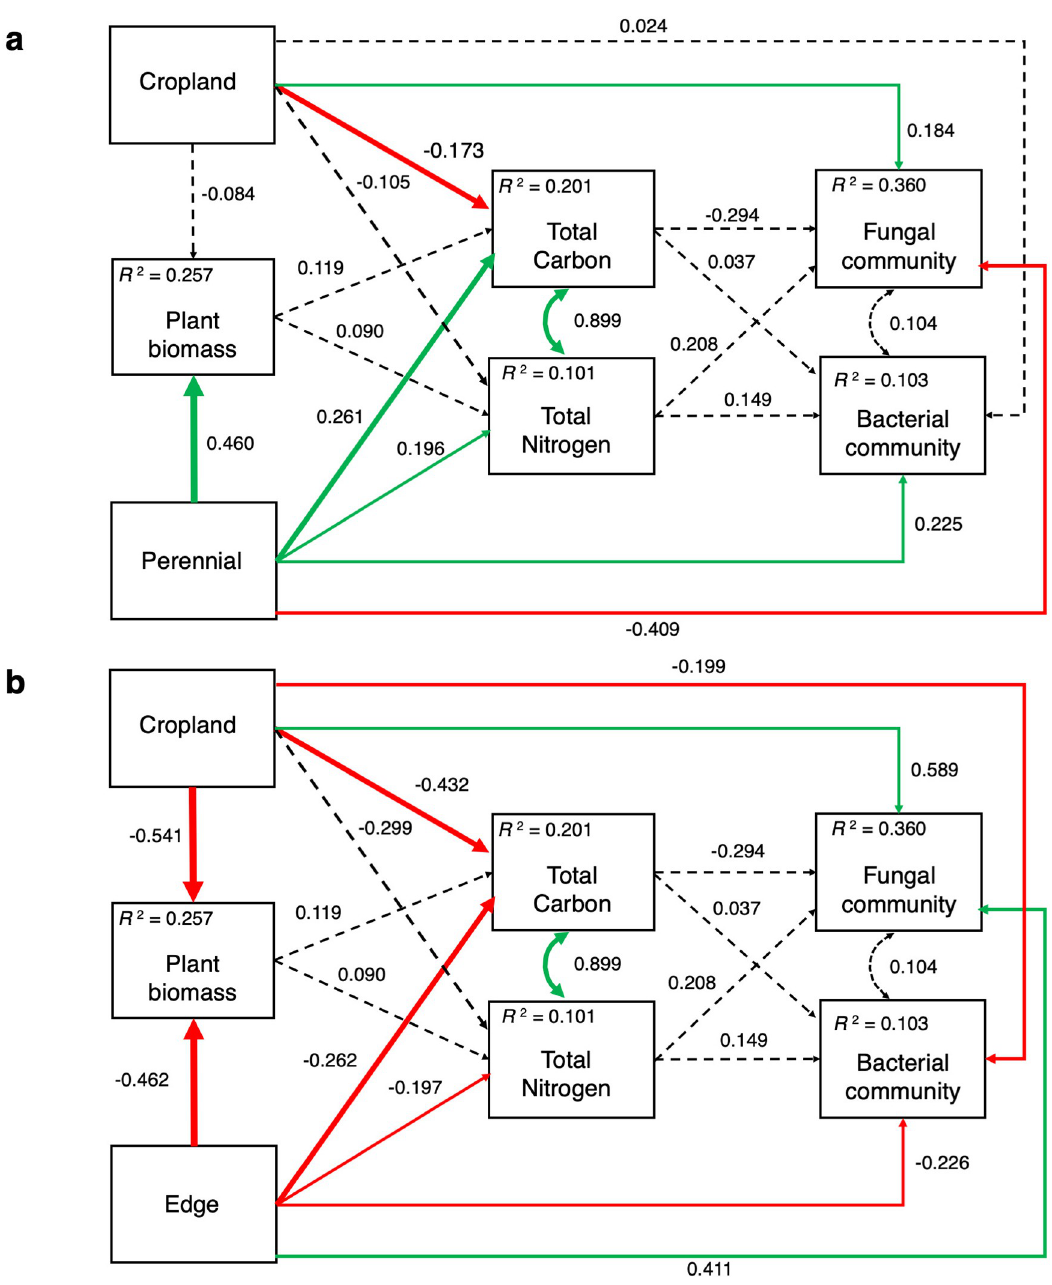
Fig 4. Structural equation model for relationships between land management, microbial communities, soil properties, and vegetation. Final structural equation model ( χ 2 p-value = 0.144, RMSEA = 0.074, CFI = 0.996) representing the causal relationships between land management, aboveground plants, soil properties and microbial communities with edge (a) and perennial (b) as the reference category. Data from both SDNWA and CLC are included. Solid arrows are significant (p < 0.05) and pathways with dashed arrows are non-significant. Green arrows represent significant positive pathways and red arrows represent significant negative pathways. Standardized partial path coefficients are beside each pathway arrow and R 2 values provided for each dependent